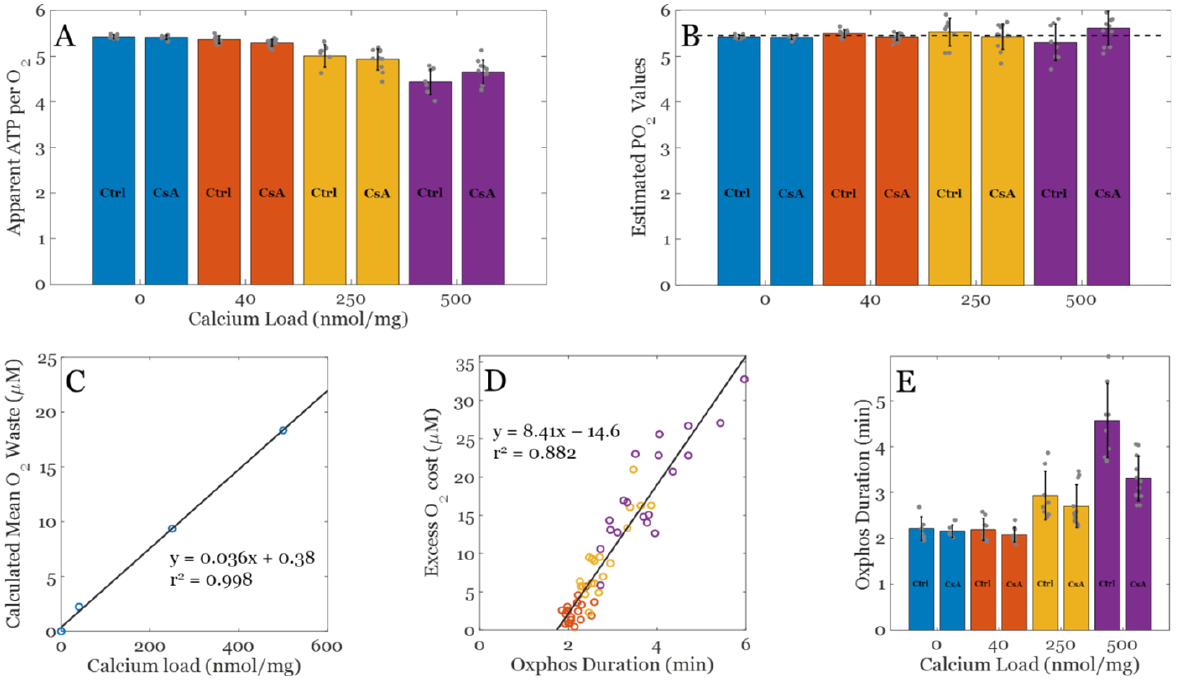
Figure 4. Analysis of O 2 cost for each experimental condition. ( A ) Observed ADP consumed (ATP produced) per O 2 across a range of calcium loads with and without CsA. ( B ) Estimated ATP/O 2 ratios across a range of calcium loads with and without CsA. The theoretical PO 2 value for NADH linked substrates is approximately 5.46 assuming 8/3 + 1 H + per ATP generated and exported and 20 H + per O 2 consumed. ( C ) Calculated mean O 2 waste during the oxphos period used to correct apparent ADP per O 2 data shown in panel A to estimate the PO 2 values shown in panel B. ( D ) Calculated excess O 2 cost plotted against oxphos duration from panel C. ( E ) Oxphos duration estimated from data for each condition. Color key: blue, EGTA; orange, 40 nmol/mg, yellow, 250 nmol/mg, and 500 nmol/mg Ca 2+ condition. Data are presented as the mean ± standard deviation for a sample size of n ≥ 8 .